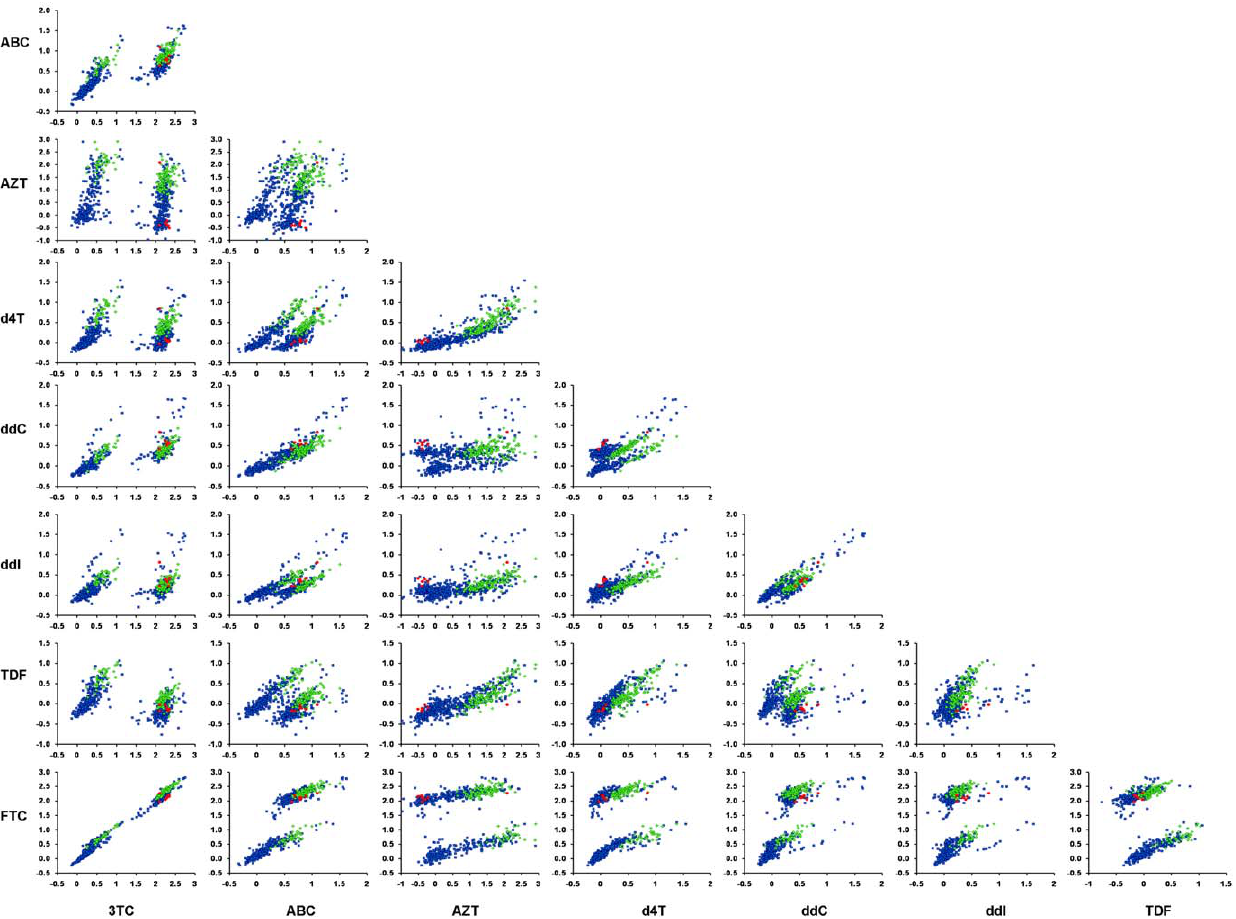
Figure 4. Pair-wise comparisons of NRTI susceptibilities. Shown are pair-wise comparisons of NRTI susceptibilities for mutant HIV variants, predicted from the proteochemometric model ( Model-3 ). The figure represents the computed susceptibilities for all mutation combinations occurring in the data-set; red symbols represent predictions for the seven RT variants in the data-set that contained the double mutations K65R + M184V; green symbols represent the susceptibilities for 153 variants containing the triple mutations M41L + L210W + T215; the blue symbols represent predictions for 568 other RT variants in the data-set retrieved from the Stanford HIV database.